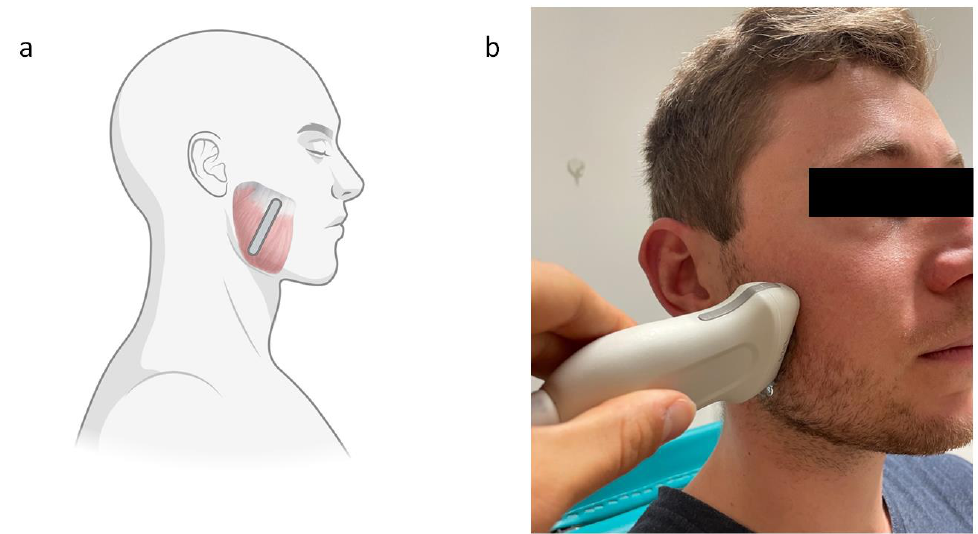
Figure 1. ( a ) Schematic illustration, and ( b ) clinical illustration, of the probe on the masseter muscle during a shear wave elastography